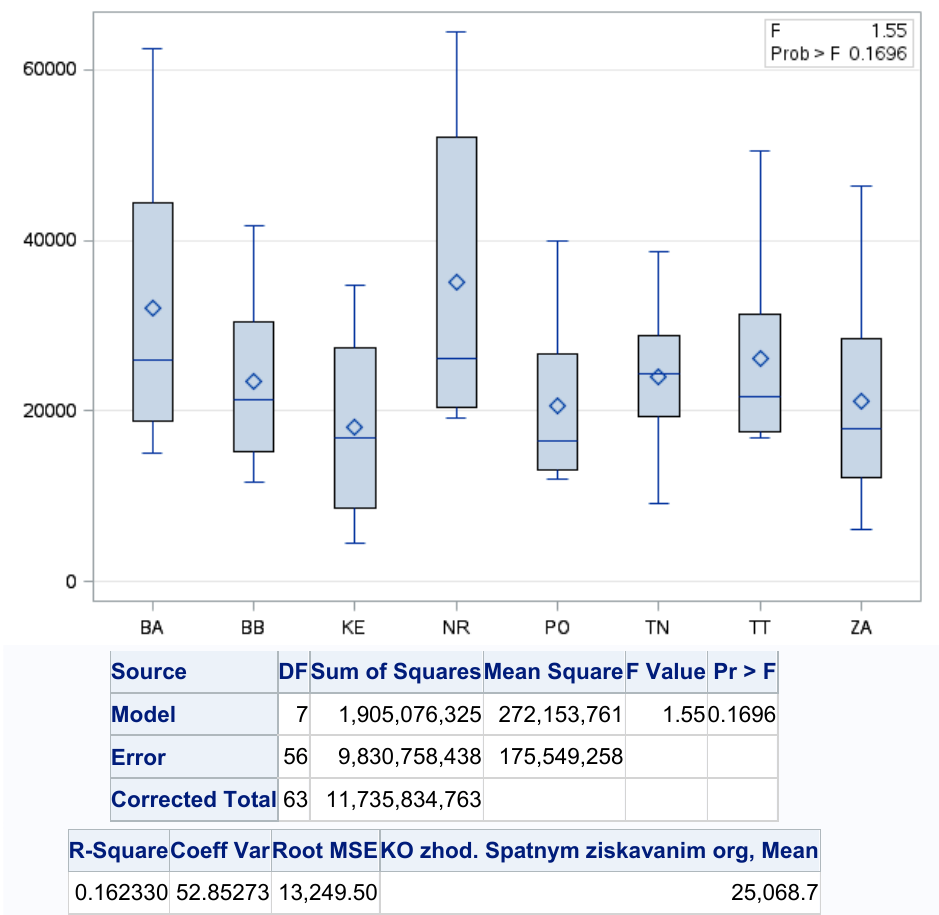
Figure 8. One-factor analysis of backward obtained organic materials. Source: Based on of data collected by Statistical Office of Slovak Republic [29].